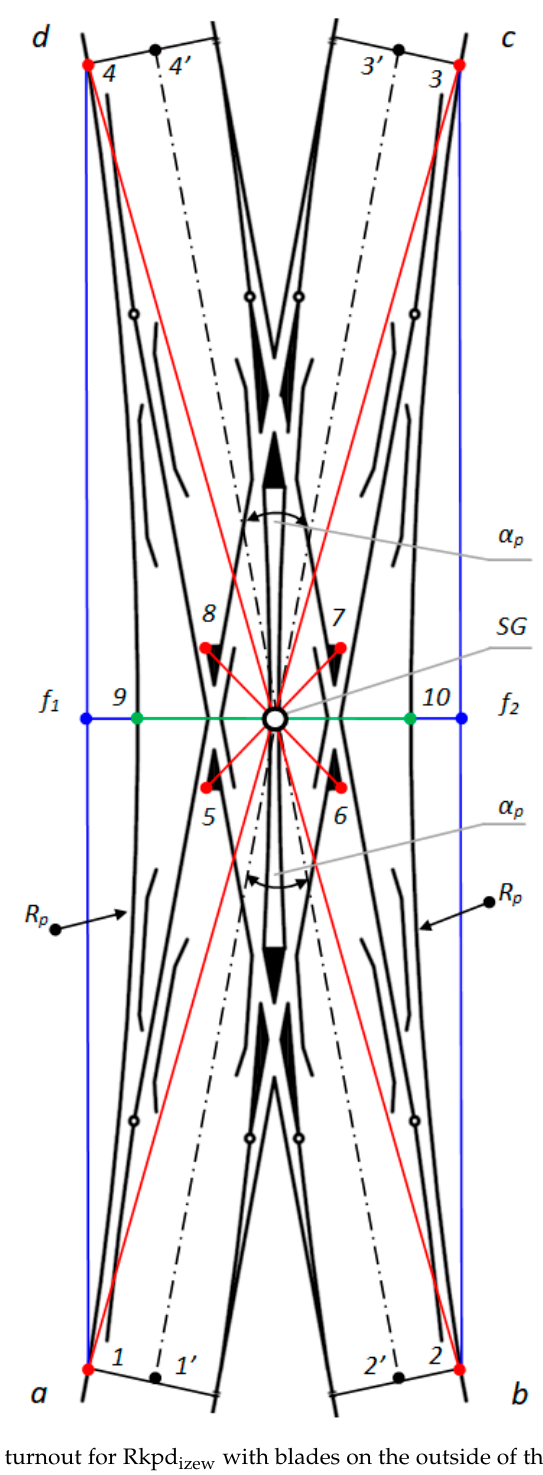
Figure 6. Outside slip turnout for Rkpd izew with blades on the outside of the quadrangle using the SMDOST method.